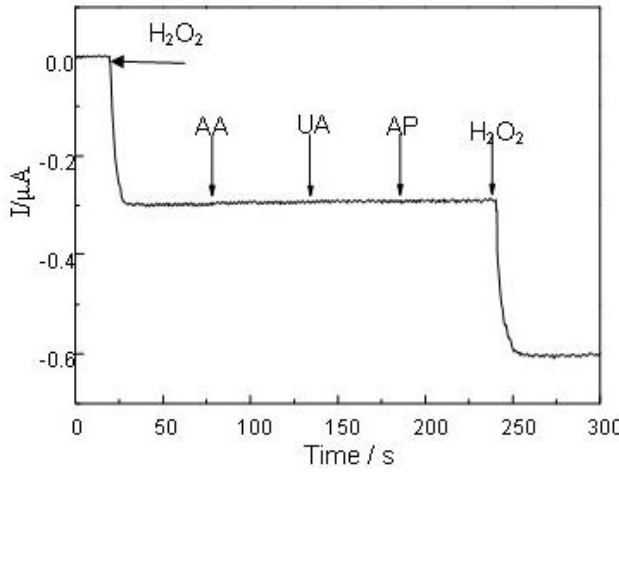
Figure 5. Amperometric responses of the MWCNTs/Pt NPs/Pt electrode upon